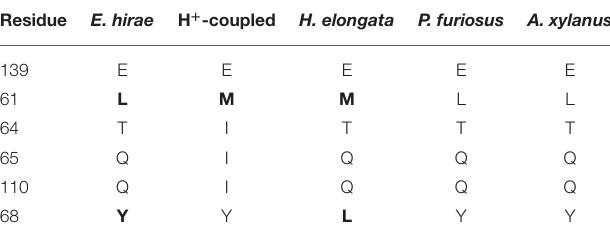
TABLE 3 | Overview of the essential residues for H + - and Na + -binding of the translocating subunit in V-type ATPases (Murata et al., 2005).